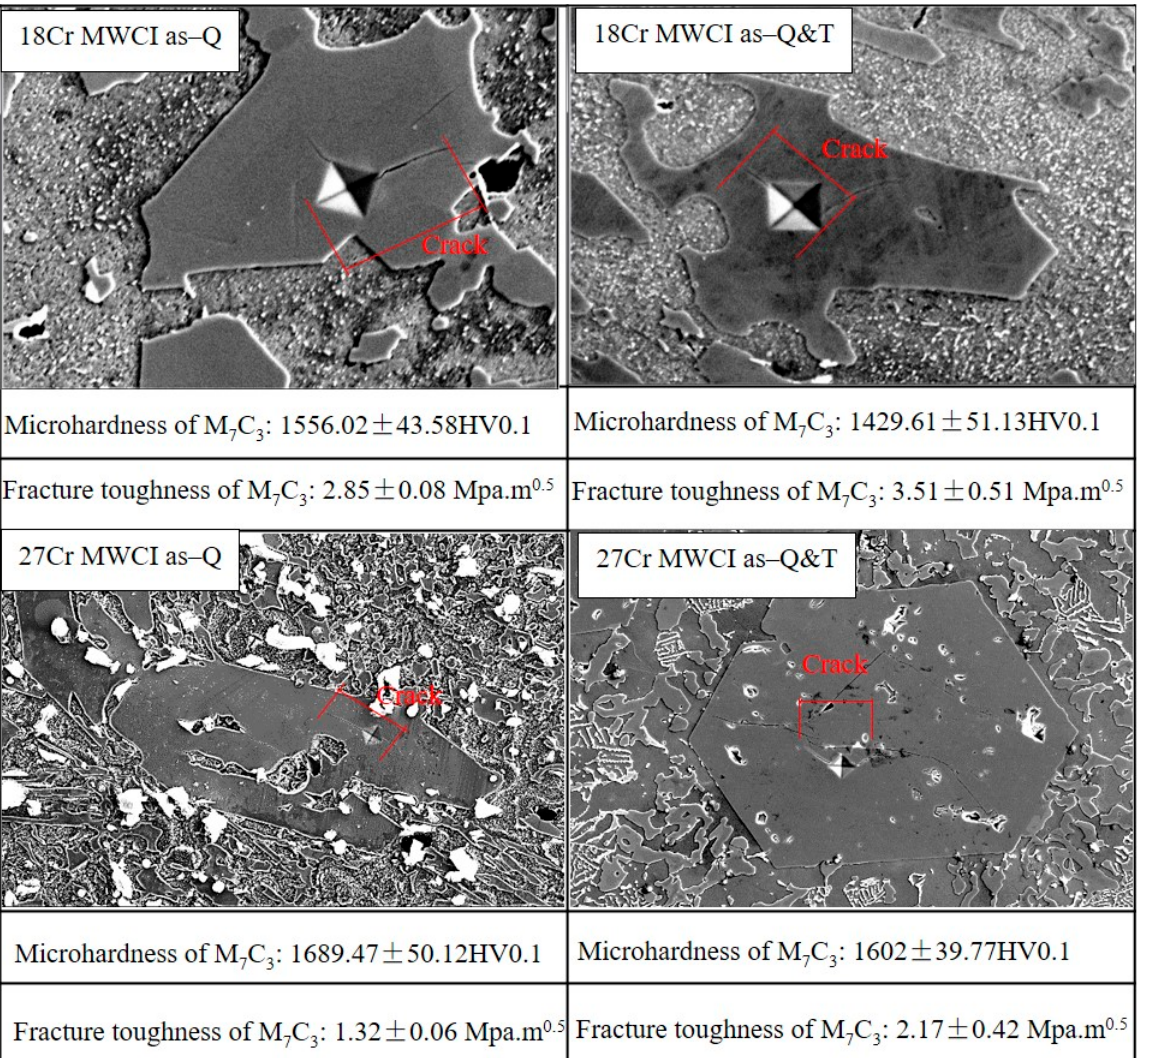
Figure 14. Footprint images after micro-indentation and properties (hardness and fracture toughness) of M 7 C 3 carbide.